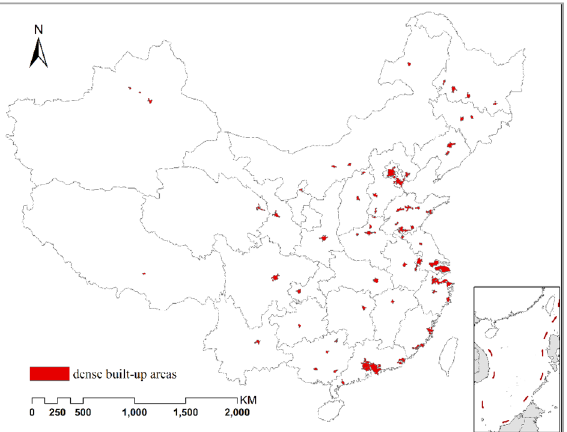
Figure 4. The distribution of the selected homogeneous areas covering dense built-up areas. The fig was generated using the ArcGIS Desktop (ESRI, Inc, Version 10.2, https:// deskt op. arcgis. com/ zh- cn/).